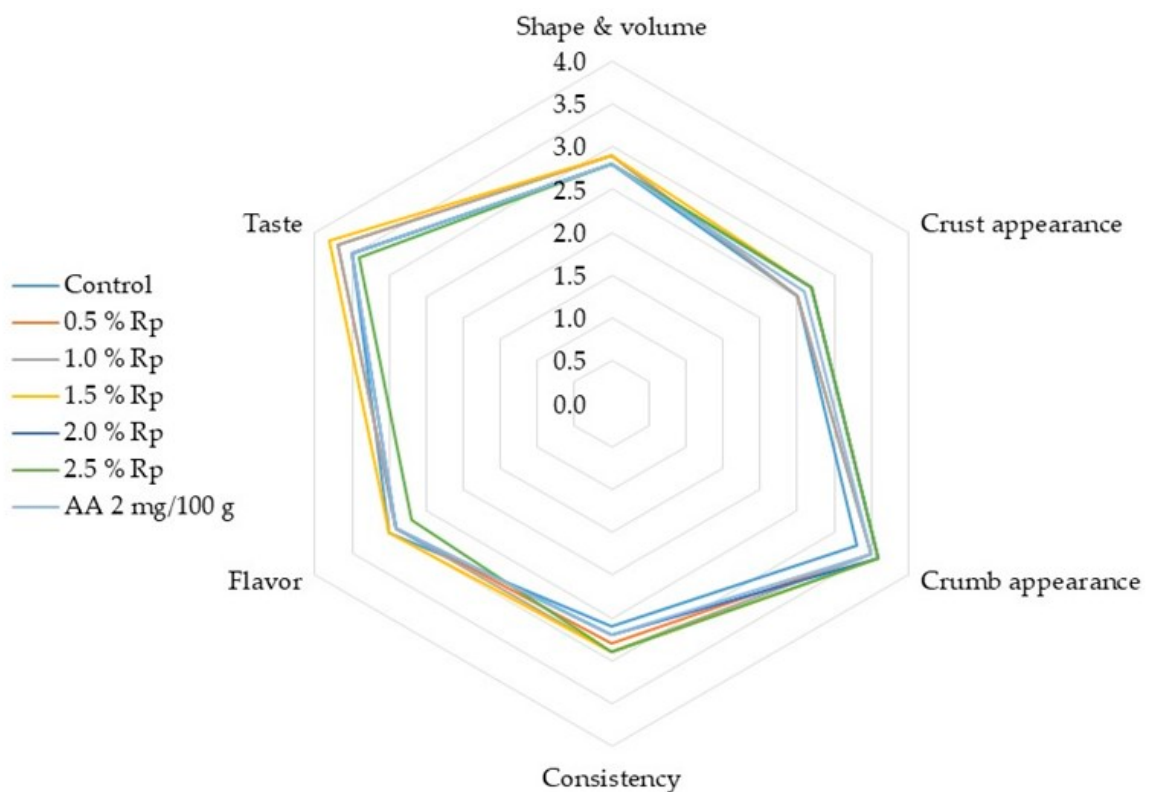
Figure 7. Sensory pro fi le of bread with Rp addition based on the 20-point test.